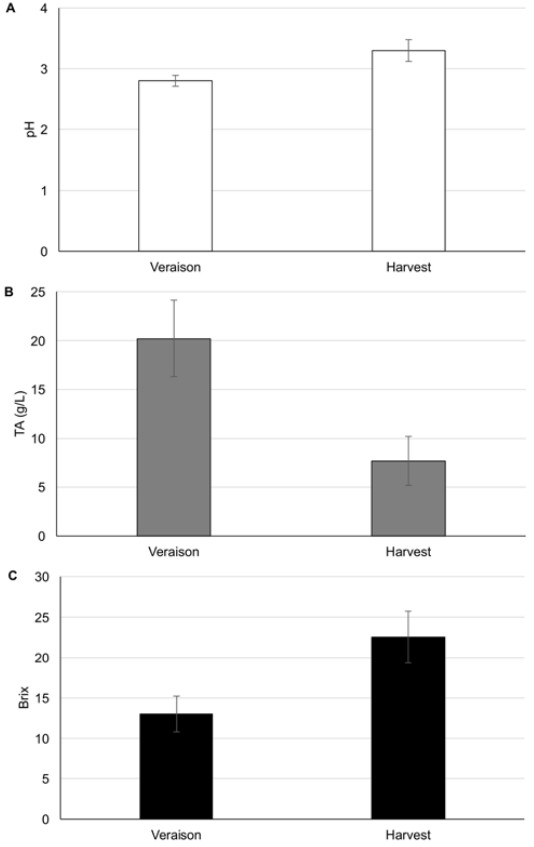
Figure 1. Summary statistics of significant mean values from analysis of pH ( A ); titratable acidity in g/L ( B ) and soluble solids as Brix ( C ) at veraison and harvest. Bars indicate the standard deviation.